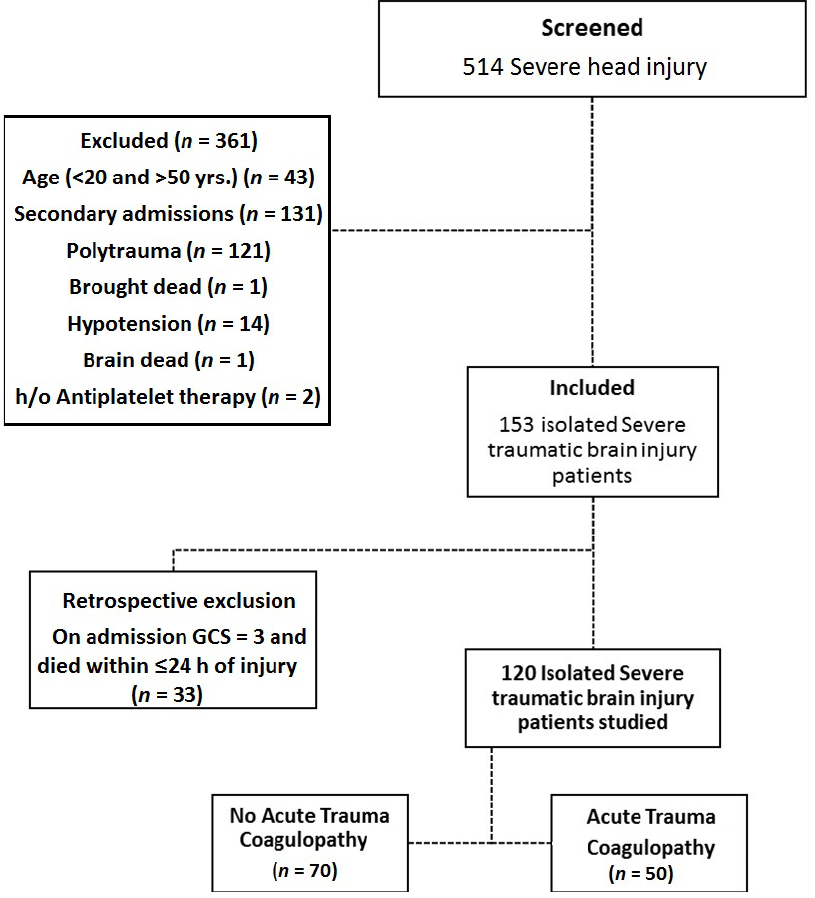
Figure 1. A Consolidated Standards of Reporting Trials (CONSORT)-like diagram showing the selection process used to identify traumatic brain injury patients for inclusion in the study. GSC: Glasgow Coma Scale; h/o: history